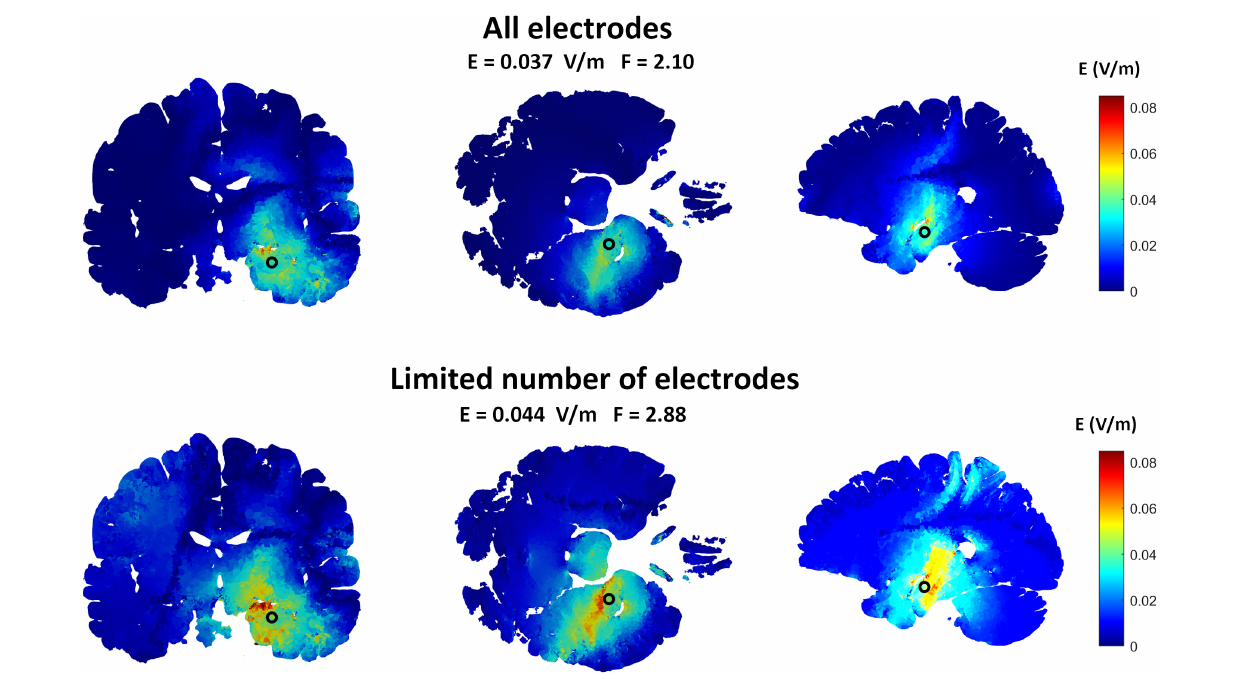
FIGURE 4 | The effects of limiting the number of implanted ECS electrodes on the induced interferential field to target the hippocampus. The upper row shows the electric field distribution obtained by the ECS grand optimal electrode configuration when all the electrodes were used while the lower row shows the fields obtained when only the most essential electrodes were selected. The most essential electrodes were defined as the electrodes contributing to at least 75% of the injected current for both sources. This was a total of seven electrodes in this example. As shown, the fields are a bit less focused when the number of electrodes were decreased. But by readjusting the total amount of injected current to reach the maximum allowed values (1 mA peak amplitude), the electric field amplitude at the target was higher. This is in line with the amplitude-focality trade-off already discussed in this paper.